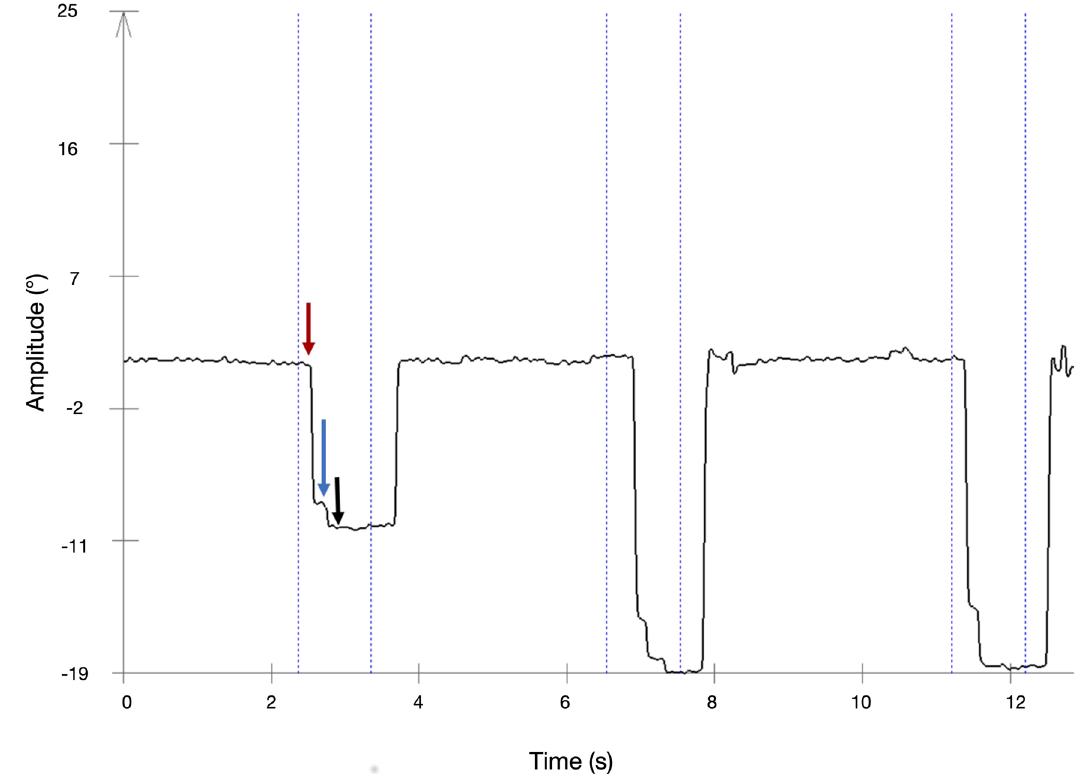
Fig. 2 Oculographic recording of the left eye of a representative patient with PD, undergoing STN-DBS stimulation at 130 Hz. Traces represent horizontal eye movements (a downward de fl ection corresponds to a leftward eye movement). The onset of a saccade (vertical red arrow) was automatically detected using the eye-tracker software, but all traces were visually inspected for consistency and accuracy. The blue arrow indicates the fi rst ‘ landing point ’ of the saccade trajectory (hypometry in this example), and the black arrow indicates the end of the saccade. Saccade latency was measured as the time between stimulus onset (dotted blue line) and saccade onset (red arrow). Saccade gain was calculated as the ratio between the amplitude of the fi rst saccadic “ landing point ” (approximately 7.5 degrees, blue arrow) and the maximum saccadic amplitude (approximately 10 degrees, for the saccade in this